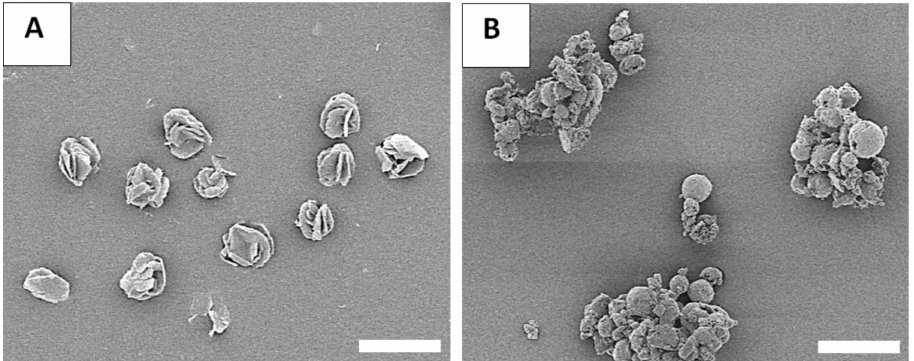
Figure 4. High-resolution SEM imaging of ( A ) ILDF particles used for our inhalation delivery; and ( B ) microparticles formed from 0.3% solution of L-isoleucine:DPPC:Glucose = 10:10:80 using 70% ( v / v ) ethanol:water. All scale bars = 20 µ